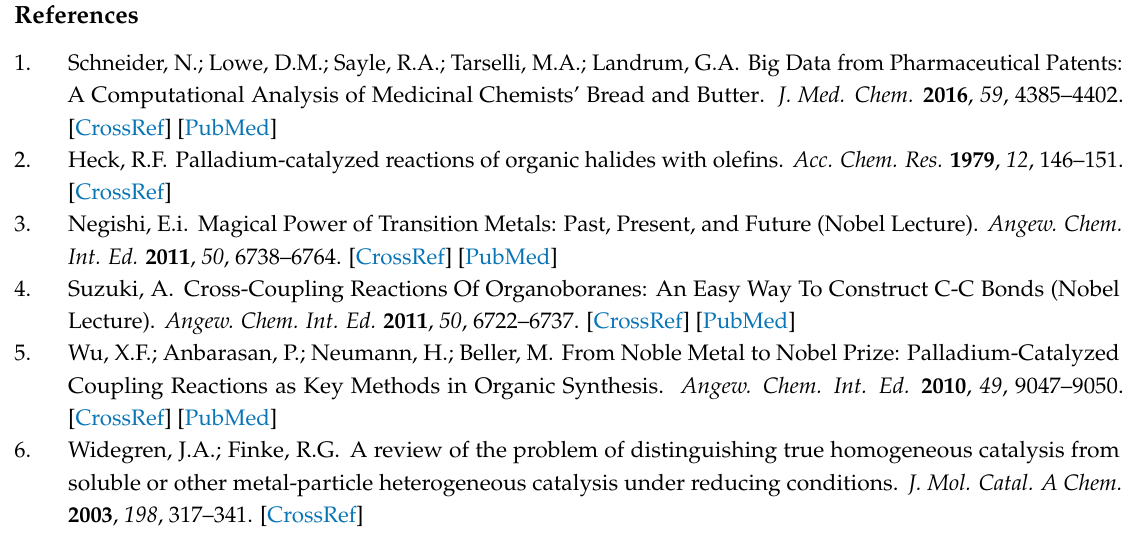
Figure S1: List of the tested homogeneous catalysts, Figure S2: Choice of the base, Figure S3: Effect of palladacycle pre-dissolution in toluene, Figure S4: Verification that the reaction is not limited by micro-mixing or mass transfer, Figure S5: Method of initial rate determination, Table S1: Catalyst selection for the Suzuki-Miyaura coupling of 4-iodoacetophenone with phenylboronic